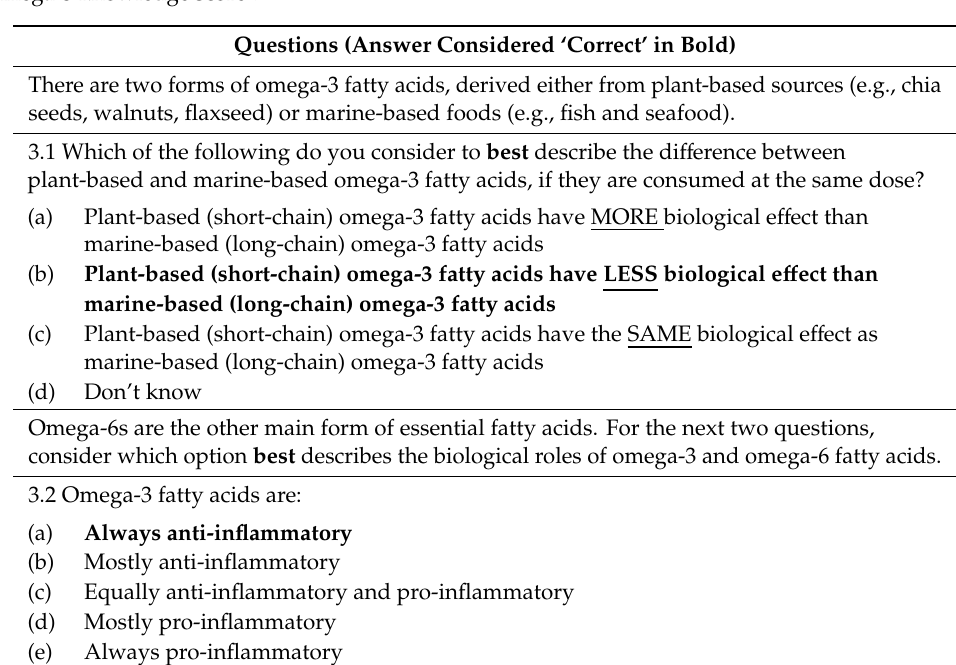
Table A1. Knowledge questions surveyed and, in bold, answers considered as ‘correct’ for deriving an ‘omega-3 knowledge